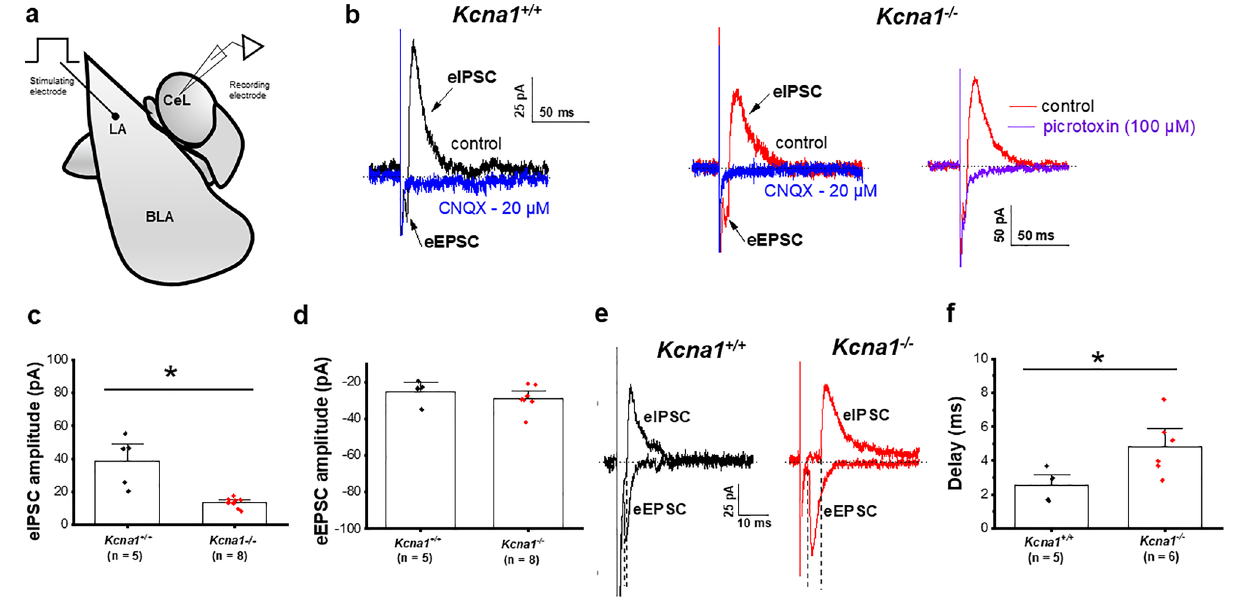
Figure 5. Kcna1 −/− mice exhibit impaired feed-forward inhibition in the LA-CeL pathway. (a ) Schematic of a coronal section of amygdala complex showing the stimulating electrode placed in the LA to evoke synaptic responses onto CeL neurons. ( b ) Representative synaptic current traces evoked by LA stimulation were recorded from CeL interneurons in Kcna1 + / + (left) and Kcna1 −/− (right) mice at a holding potential of − 20 mV. LA stimulation resulted in a biphasic response, composed on monosynaptic glutamatergic (eEPSC) and a disynaptic (eIPSC) component. Application of CNQX (20 µM, blue trace) abolished both the eEPSC and eIPSC confirming that eIPSC component is driven by excitatory synapses on inhibitory mITC neurons projecting onto CeL neurons of both in Kcna1 + / + and Kcna1 −/− mice. In Kcna1 −/− mice, the outward currents was blocked by GABA A receptor antagonism, picrotoxin (100 µM, violet trace), suggesting that eIPSCs were mediated by a disynaptic response. ( c , d ) Mean values of eIPSC (c) and eEPSC (d) amplitude. The data show that eIPSC amplitude was significantly reduced in Kcna1 −/− mice compared to Kcna1 + / + mice. No significant changes in eEPSC amplitude were observed. Kcna1 + / + , n = 5 cells from 4 mice; Kcna1 −/− , n = 8 cells from 5 mice. ( e ) Representative eEPSC and eIPSC currents evoked by LA stimulation were recorded from CeL interneurons in Kcna1 + / + (black trace) and Kcna1 −/− (red trace) mice at a holding potential of 0 mV (eIPSC) and − 70 mV (eEPSC). To measure the synaptic delay between the eEPSC and eIPSC components the peak of the eEPSC and eIPSC currents were measured and the 10% level was detected (dashed lines). ( f ) Mean values of the synaptic delay between the eEPSC and eIPSC component. The data show that synaptic delay was significantly longer in Kcna1 −/− mice compared to Kcna1 + / + mice. Kcna1 + / + , n = 5 cells from 4 mice; Kcna1 −/− , n = 6 cells from 5 mice. Together, the reduction of the eIPSC lateral amygdala. The schematic shown in a was made using curved line tool in PowerPoint. *p <